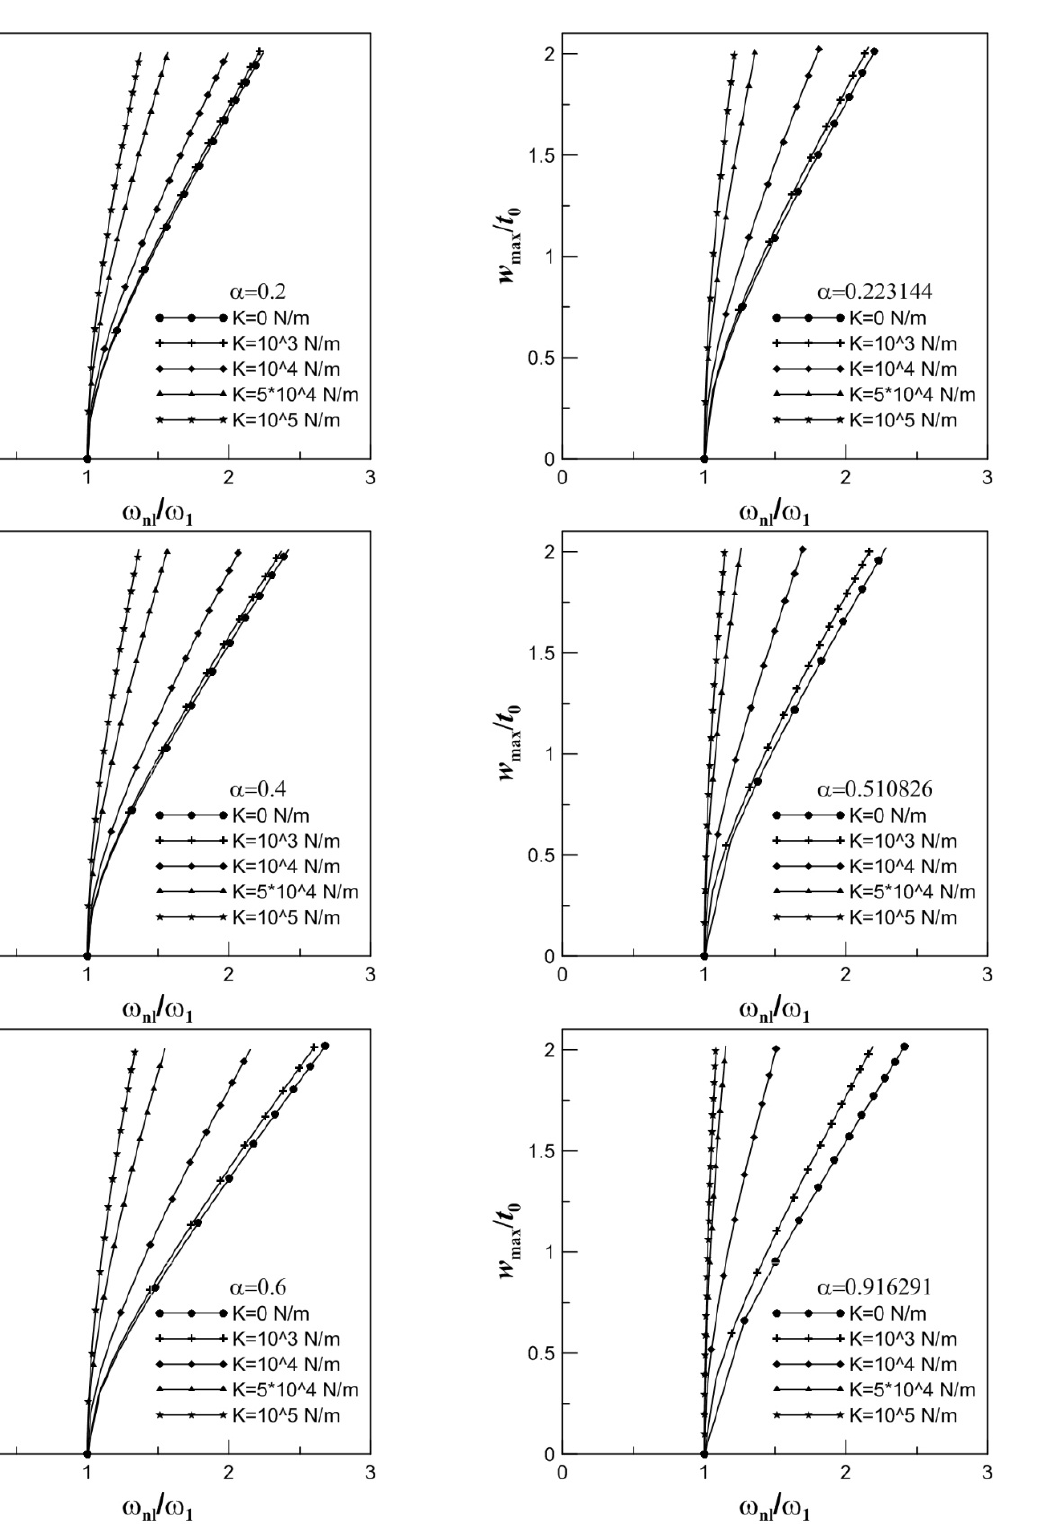
Figure 8: Backbone curve of AFG parabolic taper beam (︀ E ( ξ ) = E )︀ on elastic foundation. 0 e ξ , ρ ( ξ ) = ρ 0 e ξ